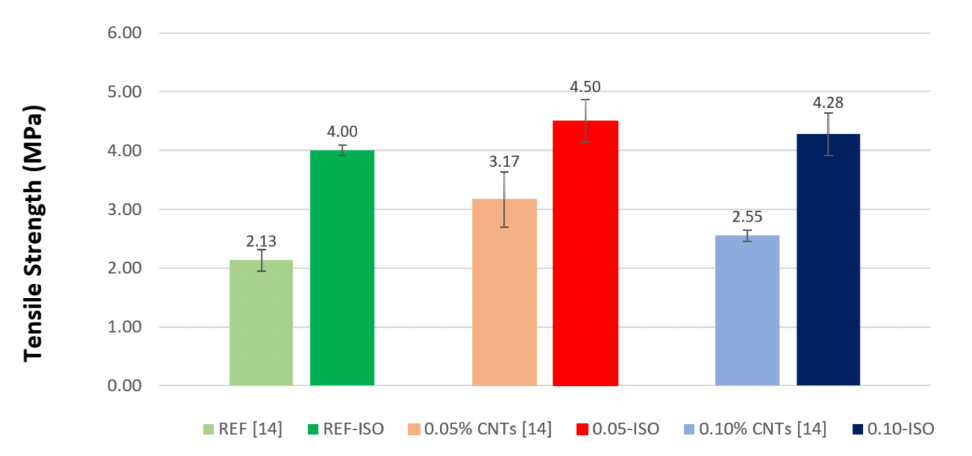
Figure 6. Tensile strength results as compared with previous results.